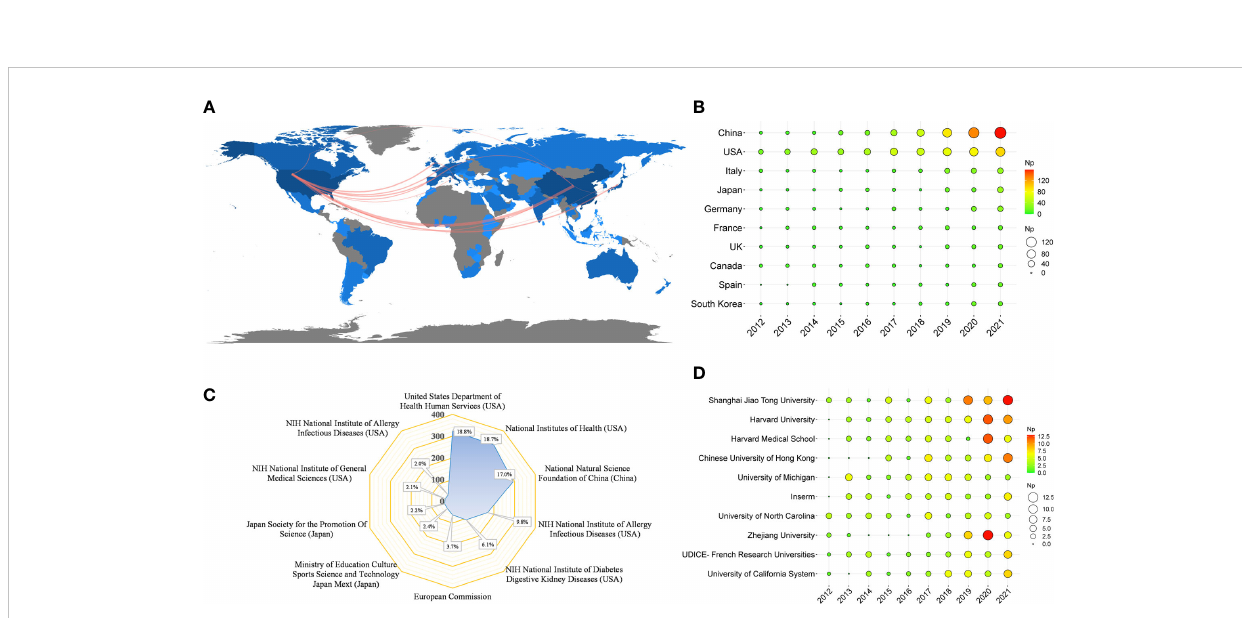
FIGURE 5 (A) Country scienti fi c production and international collaboration network (min edges set to 10) in IM/CRC. (B) Annual output of the top 10 productive countries over time in IM/CRC. (C) The top 10 funding agencies and source countries in IM/CRC research. (D) Annual output of the top 10 institutions over time in IM/CRC.